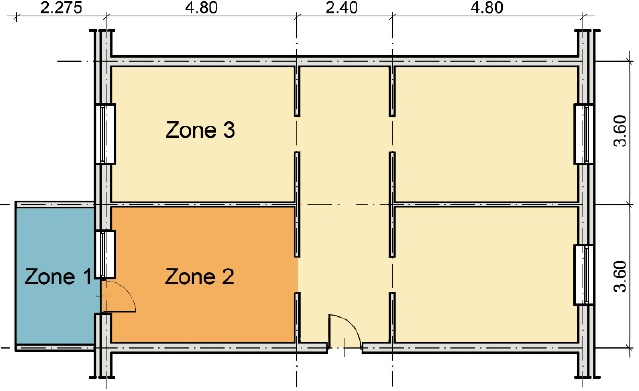
Figure 1. The modelled apartment with thermal zones.